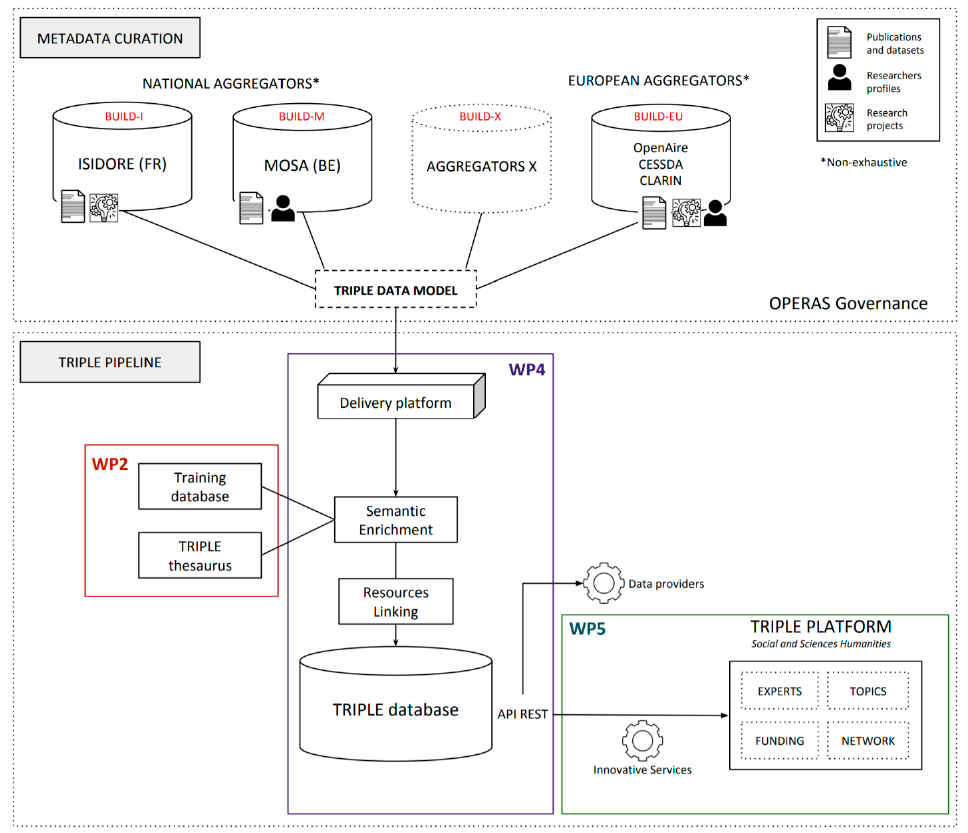
Figure 12. Schematic and simplified representation of the two-fold approach to ingest metadata in the TRIPLE database.